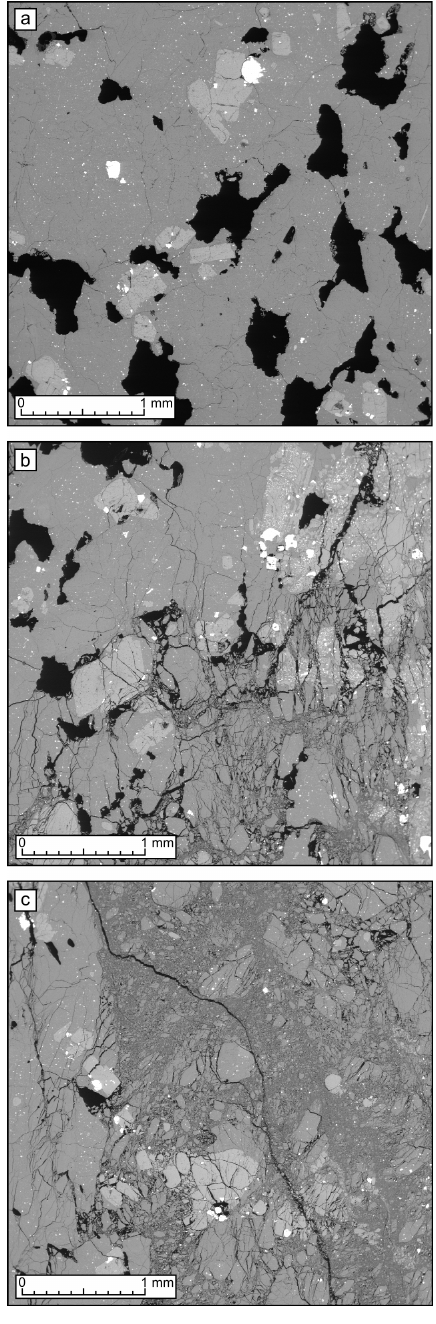
Figure 4. Backscattered scanning electron microscope images of LLB andesite, showing as-collected (a) and post-deformation (b– c) microstructure. Void space appears as black. Dense (metal-rich) phenocrysts appear as white or light grey within a darker grey groundmass. Both (b) and (c) are images of LLB-13, which was taken to beyond both C ∗ and C ∗(cid:48) . Cataclastic pore collapse as- sociated with shear-enhanced compaction is shown in (b) , while (c) shows part of the dilatant shear zone marking the transition from shear-enhanced compaction to